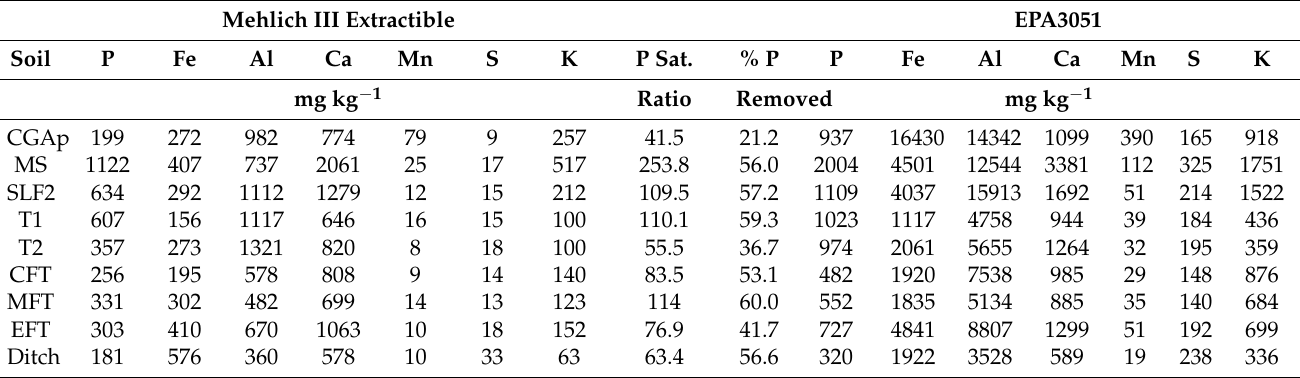
Table 1. Elemental concentrations of extractions and digestions.